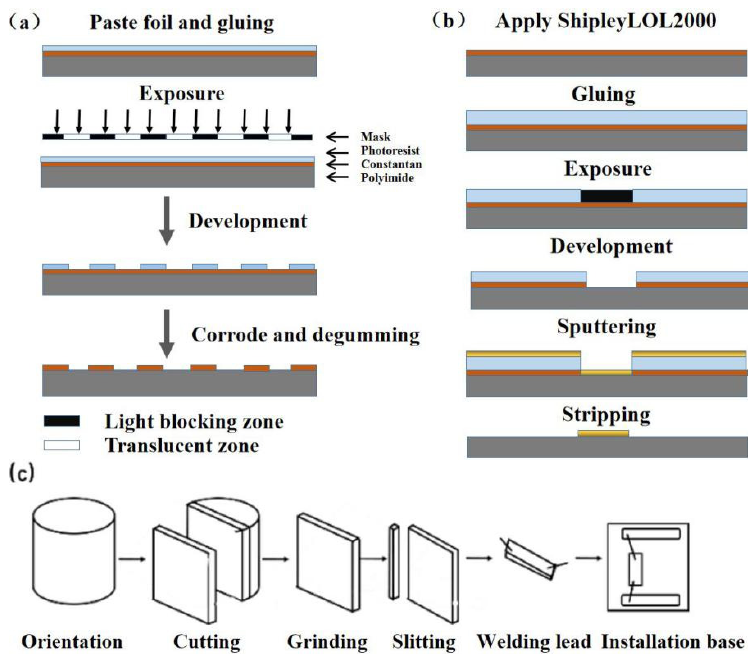
Figure 4. Strain gauge manufacturing process. ( a ) photolithography process, ( b ) sputtering and stripping process, and ( c ) manufacturing process for shaping-type strain gauges .